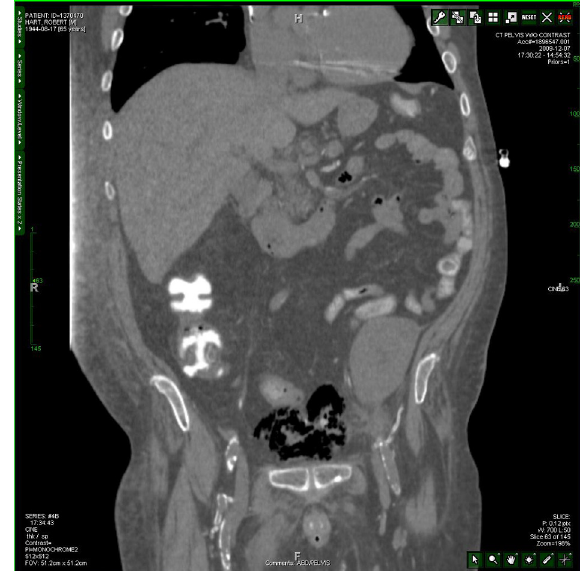
Figure 3 – �as dissecting into the ureter.�as dissecting into the